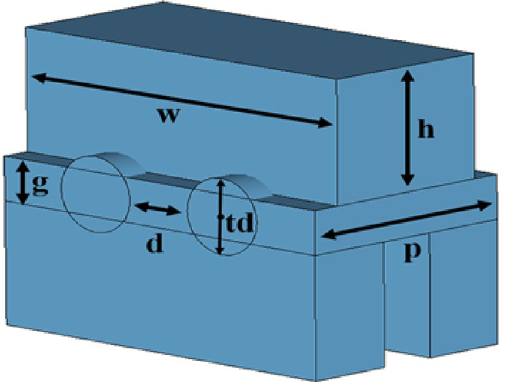
Figure 1. 3-D schematic of a unit cell of multi-beam SDV-SWS. The blue section is